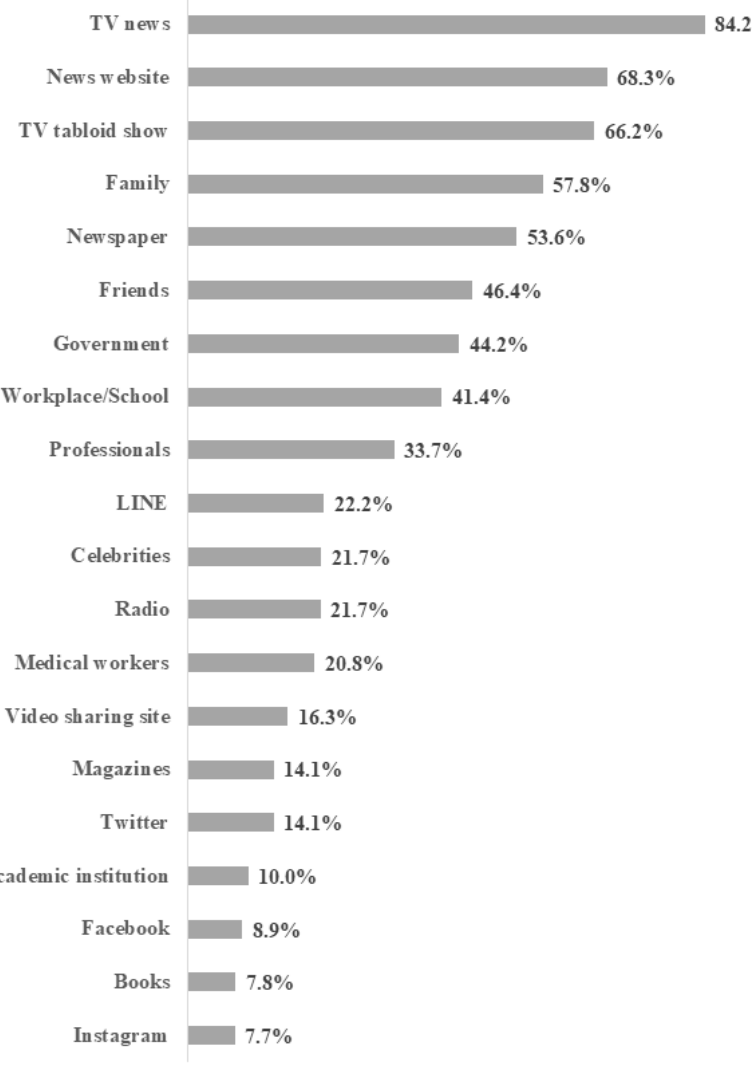
Figure 1. Weighted proportions of the use of information sources ( n = 18,151). Table 2. The compliance with preventive behaviors for COVID-19 based on the characteristics in 2020 and 2021 ( n = 18,151).